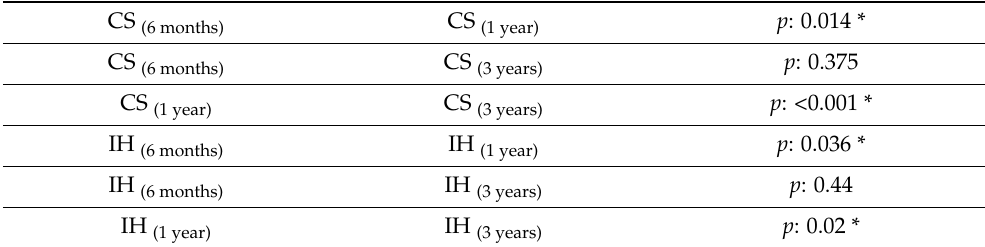
Table 3. Intragroup differences in mean bone loss. (* statistically significant).